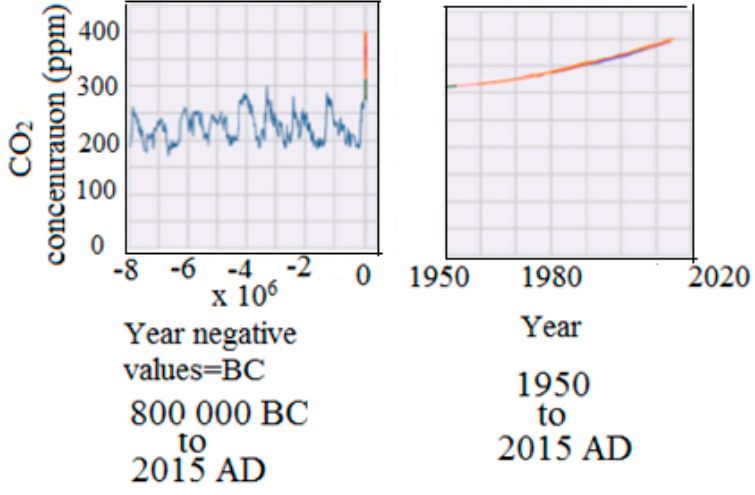
Figure 2. Global atmospheric concentrations of carbon dioxide over time. Taken from: https://www.epa.gov/climate-indicators/climate-change-indicators-atmospheric-concentrations- greenhouse-gases.